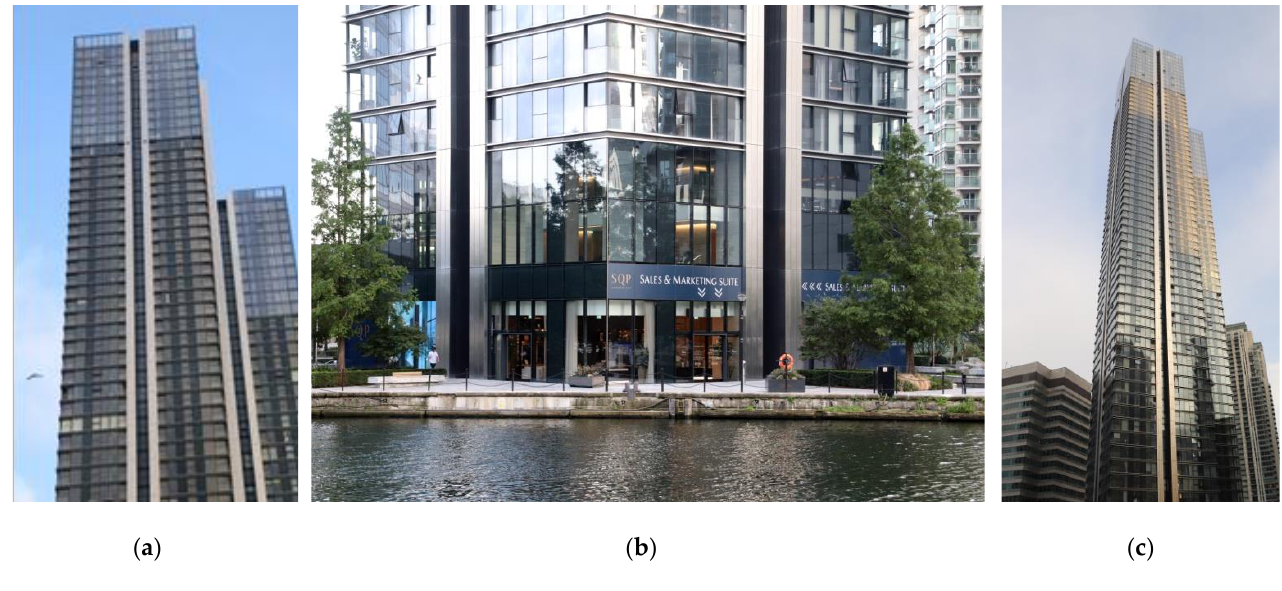
Figure 9. Simplicity of powerful detail on South Quay Plaza. ( a ) Subtle detail of the building’s top highlighted by introduction of smooth solid curtain wall over few top floors (2021), ( b ) Similar approach applied to the base of the building: First three floors of flushed glass (2021). ( c ) Different lighting conditions add colour but articulation of detail remains the same (2021).